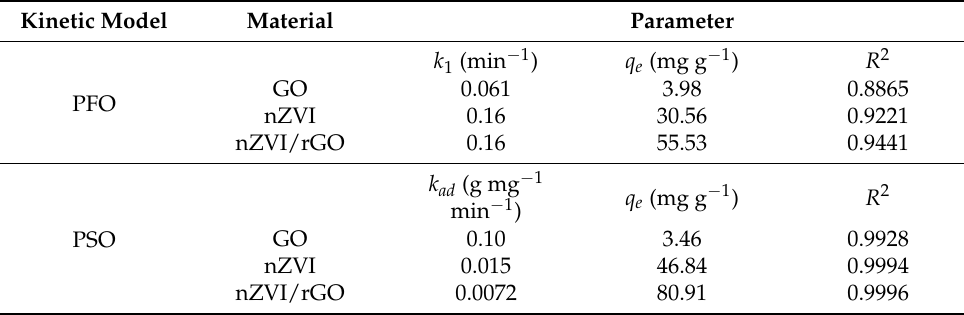
Table 2. PFO and PSO kinetic parameters for different